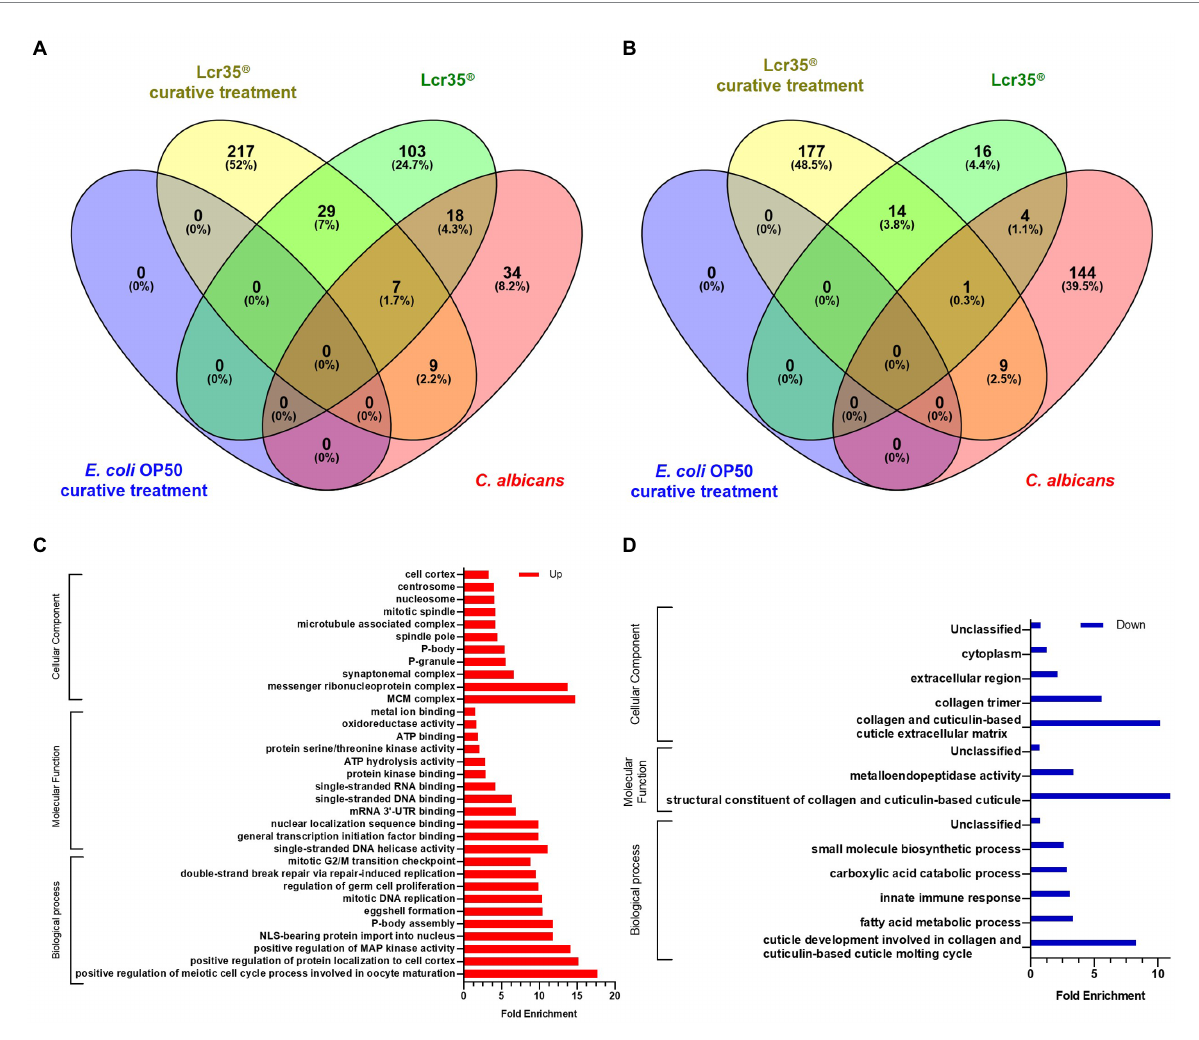
FIGURE 7 The transcriptional responses to E. coli as a curative treatment and L. rhamnosus Lcr35 ® as a curative treatment comprises specific and overlapping gene sets. Venn diagrams illustrate the overlap genes significantly upregulated (A) or downregulated (B) . Animals were exposed to the bacterial strains for 4 h and infected by the yeast for 2 h. GO analyses of upregulated expressed genes (C) or downregulated expressed genes (D) after a L. rhamnosus Lcr35 ® curative treatment compared to worms fed with L. rhamnosus Lcr35 ® only. Only GO terms significantly enriched (value of p and false discovery rate < 0.05) are